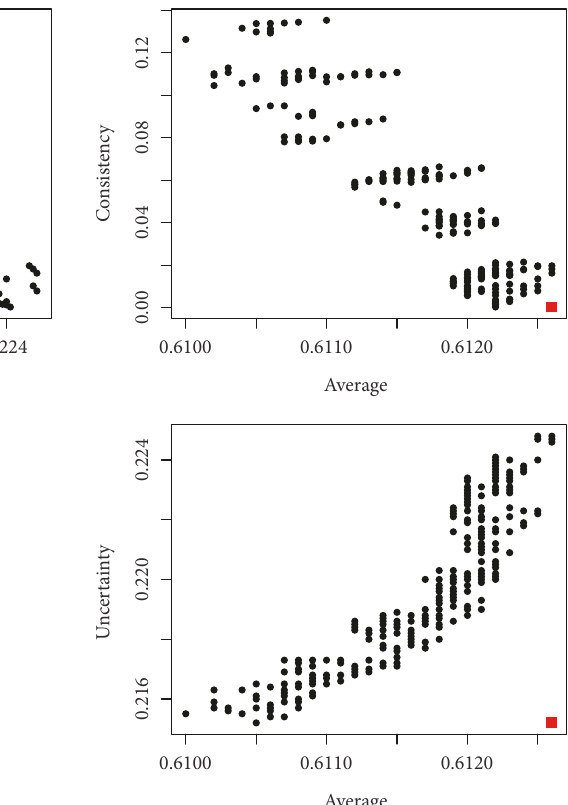
Figure 5: Pairwise scatterplotsof PhaseI Paretofront. The square symbol in eachplot representsthe Utopia point, whereboth criteria achieve their optimal